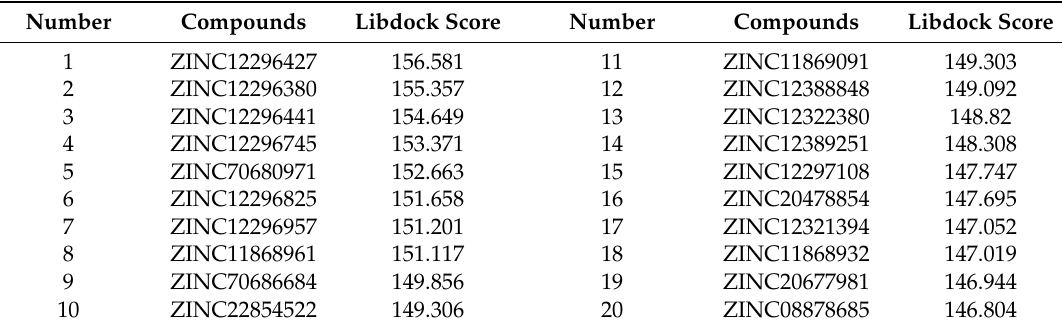
Table 1. Top 20 ranked compounds with higher Libdock scores than AZD7545.